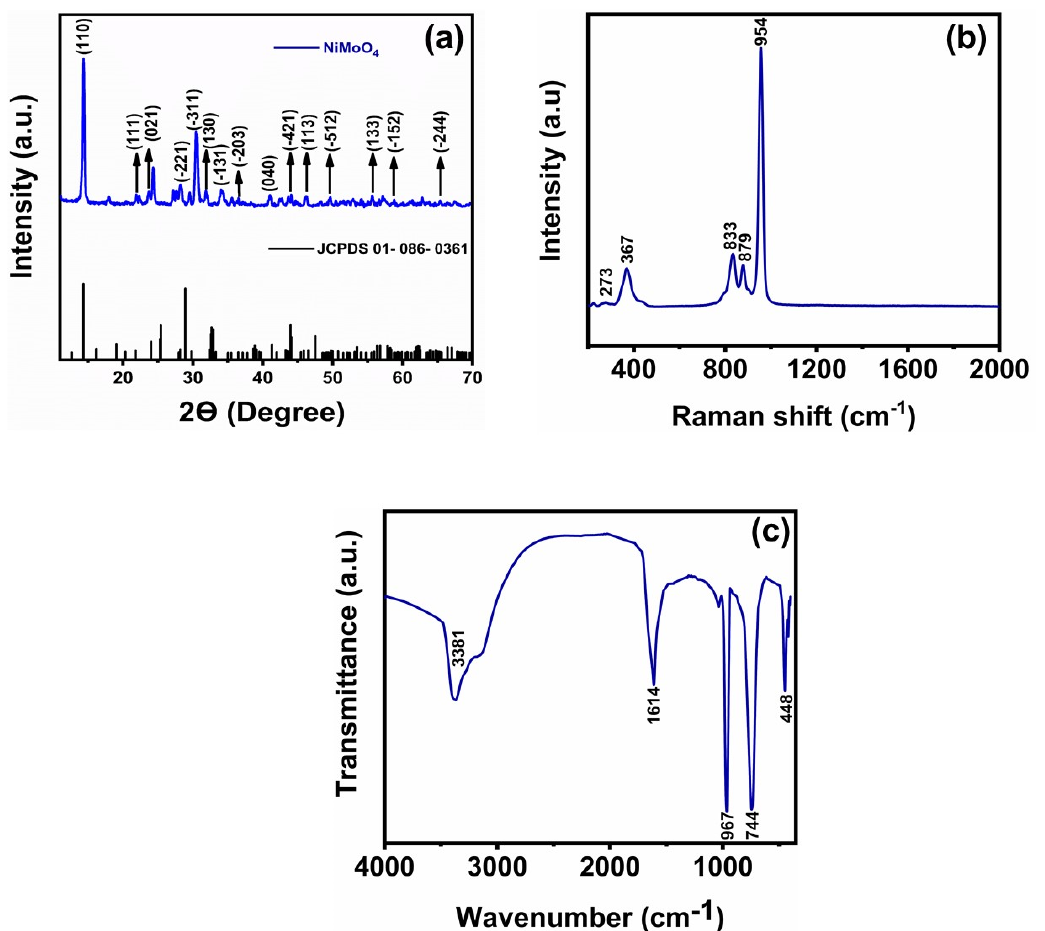
Figure 1. ( a ) XRD pattern of NMO, ( b ) Raman spectrum of NMO, and ( c ) Fourier transform infrared spectroscopy (FTIR) spectra of NMO.